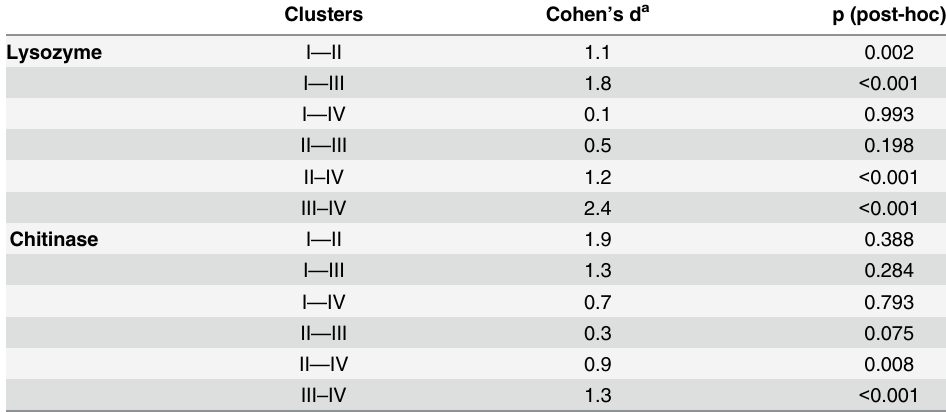
Table 4. Differences between Spectral Clustering clusters in salivary lysozyme and chitinase activity compared using one-way ANOVA and Games-Howell post-hoc tests. The magnitude of the inter-cluster differences is quantified using Cohen ’ s d measure of effect size ( i . e . the difference between the two means divided by the standard deviation of the